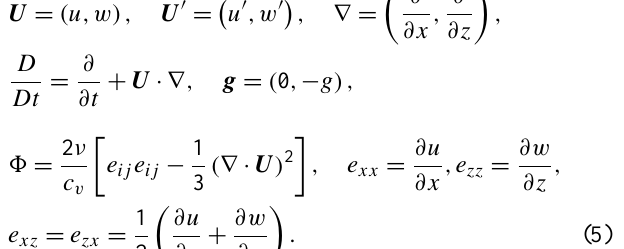
Table 1. The wavelengths and periods of the initial